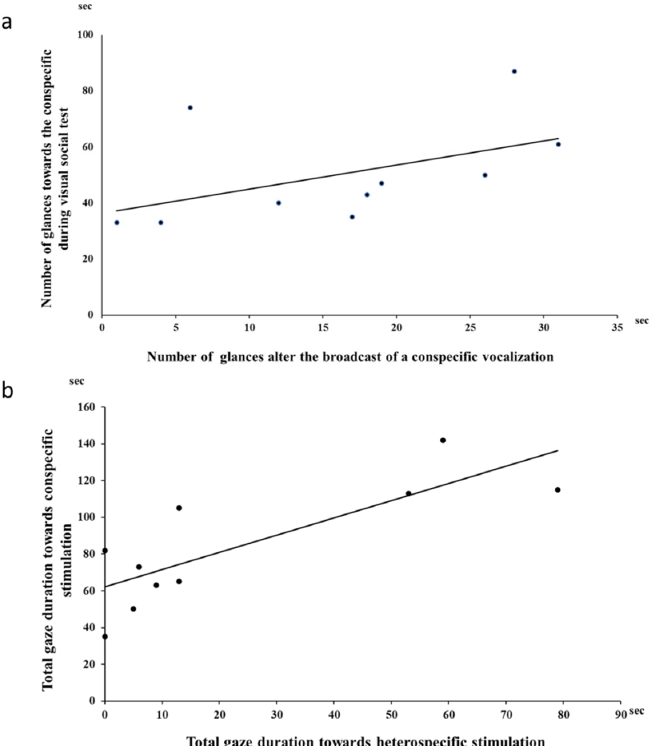
Figure 3. ( a ) Numbers of glances towards a conspecific during the visual social test (minimum opening) in relation to numbers of glances after the broadcast of a conspecific vocalization (correlation rs = 0.70, N = 10, p = 0.05). ( b ) Total gaze durations after the broadcast of the conspecific vocalization in relation to total gaze durations following the hetero-specific vocalization during auditory tests (correlation r = 0.79, N = 10, p = 0.01). Each dot represents an